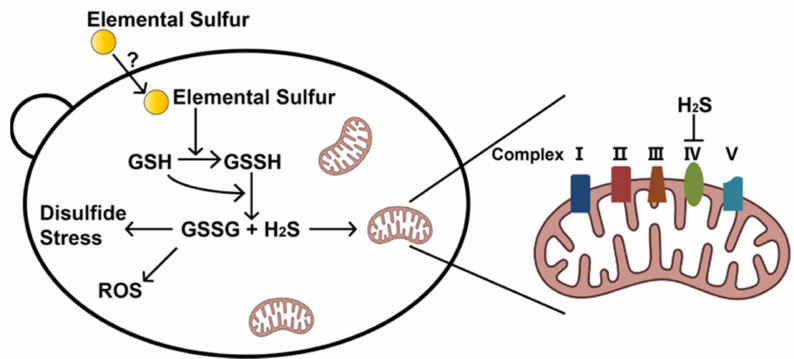
Figure 6. The inhibition mechanisms of elemental sulfur against S. cerevisiae